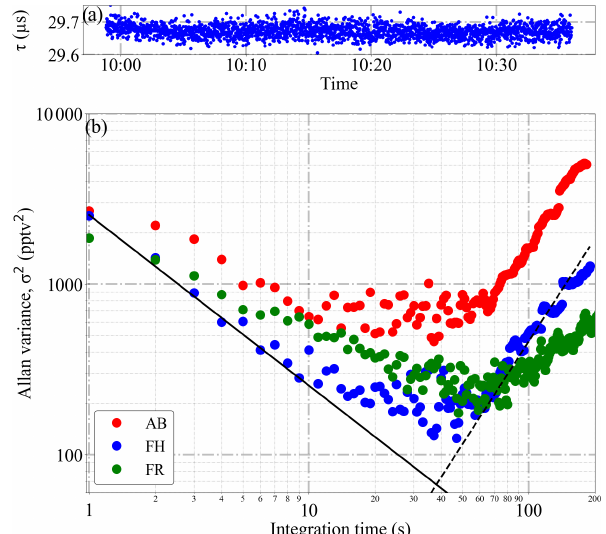
Figure 5. Analysis of the Allan variance of PeRCEAS measure- ments made in the laboratory: (a) 40min of data from detector FH used for the calculations, (b) Allan variance for a mixture of 5.6ppbv of NO 2 in air at 200mbar and 23 ◦ C sampled by the AB, FH and FR PeRCEAS detectors. The solid and dashed lines show, respectively, the theoretical behaviour of random noise (i.e. photon shot noise) and the noise attributed to longer timescale